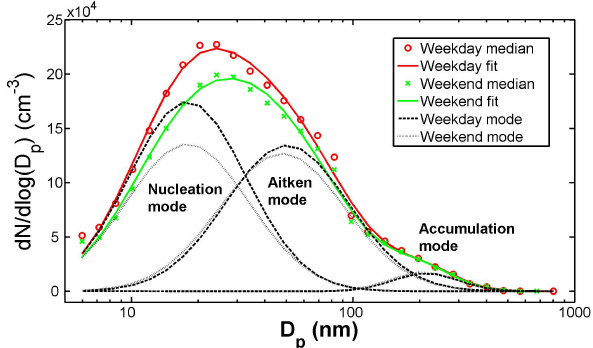
Fig. 8. The nucleation event measured on 2 November 2010. A growth rate (GR 6 − 20 ) of 9.3nmh − 1 was calculated using DMPS data from 6 to 20nm. The black circles in the upper panel indicate peaks of the size distribution. The split between NAIS and DMPS data in the picture is at 15nm.